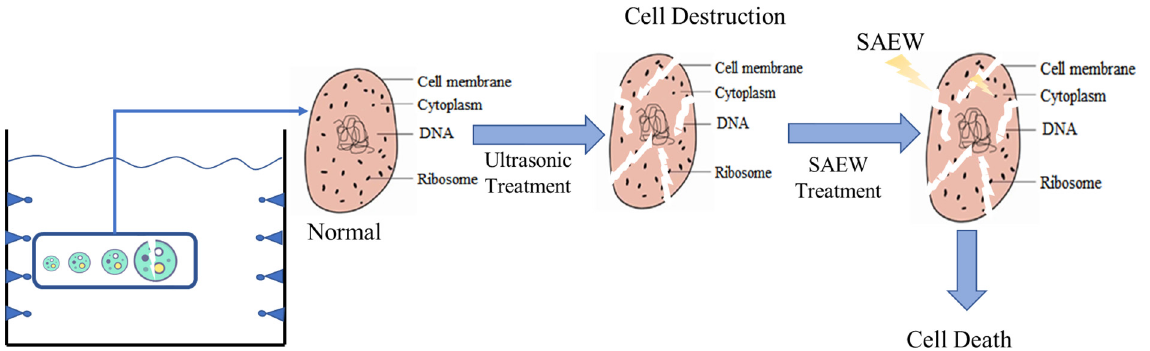
Figure 4. Reaction principle of ultrasonic and slightly acidic electrolyzed